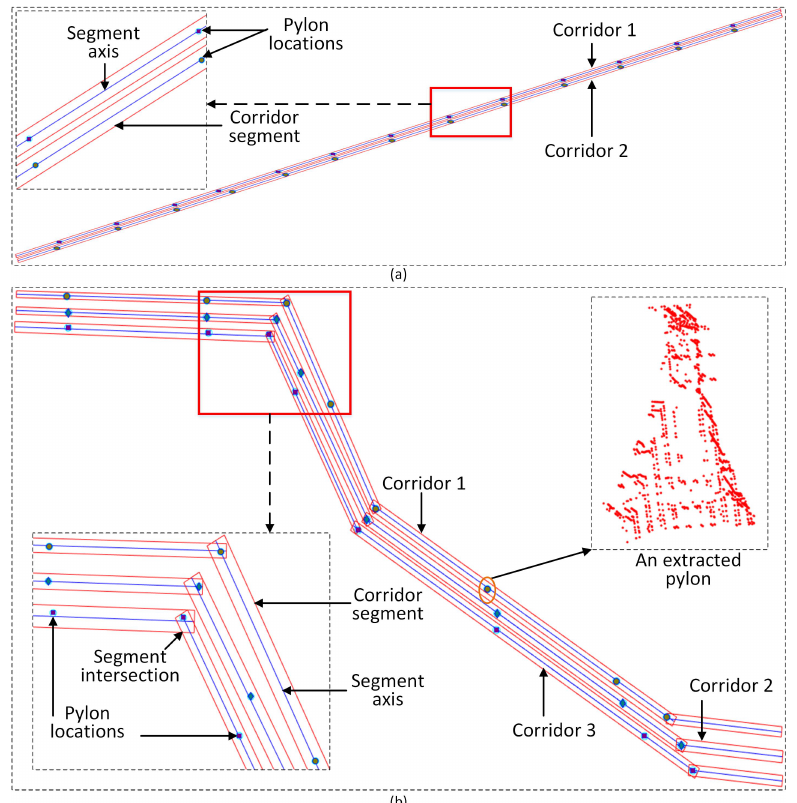
Figure 16. Extracted corridors and pylon locations in the two test datasets: ( a ) Maindample; and ( b )